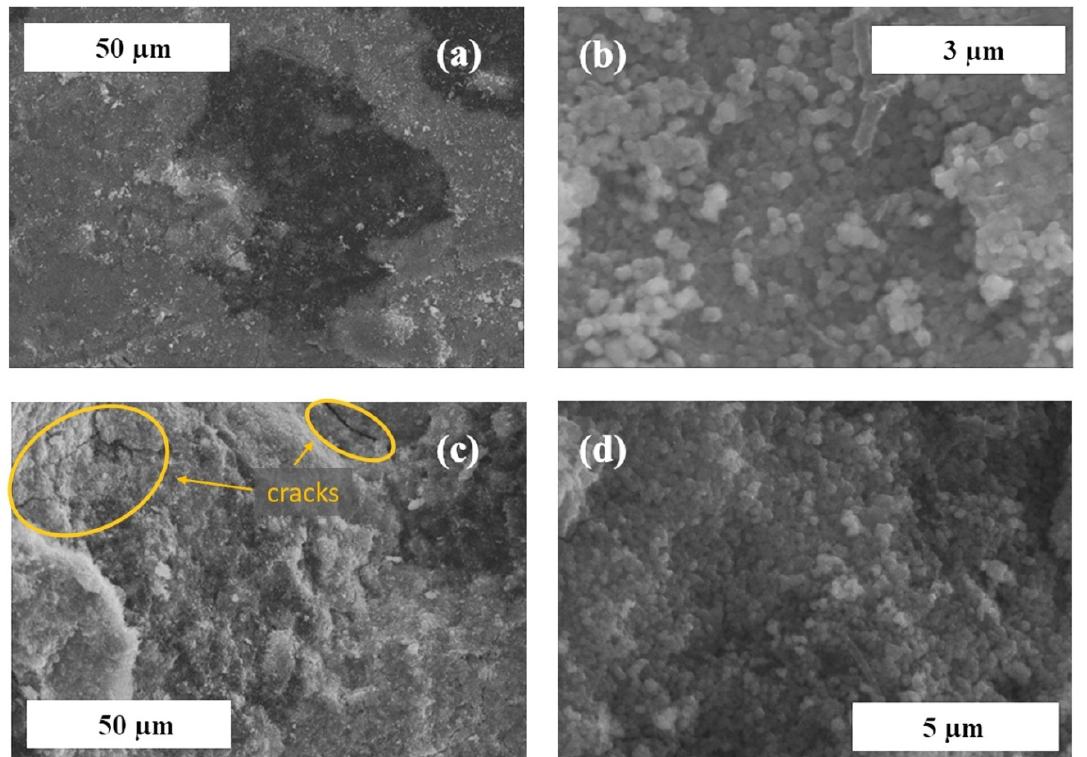
Figure 2. SEM images of ( a , b ) surface and ( c , d ) the bulk of the 90PAA membrane. Overall, macroscopic defects such as large pores, cracks or voids are absent from the surface of the 90PAA membrane. As seen from Figure 2a, the membrane is composed of brighter and darker areas. According to EDX spectra (see Figure S1 in the Supplementary Material), brighter areas correspond to the PAA phase, whereas the darker areas correspond to fluoroplastic binder. Close packing of the spherical PAA particles, both on the surface and on the membrane bulk, can be observed in Figure 2b,d. The small cracks at the cross- section are the result of brittle fracture of the membrane during the sample preparation (Figure 2c). The binder filled up the voids between PAA particles, but its content was not